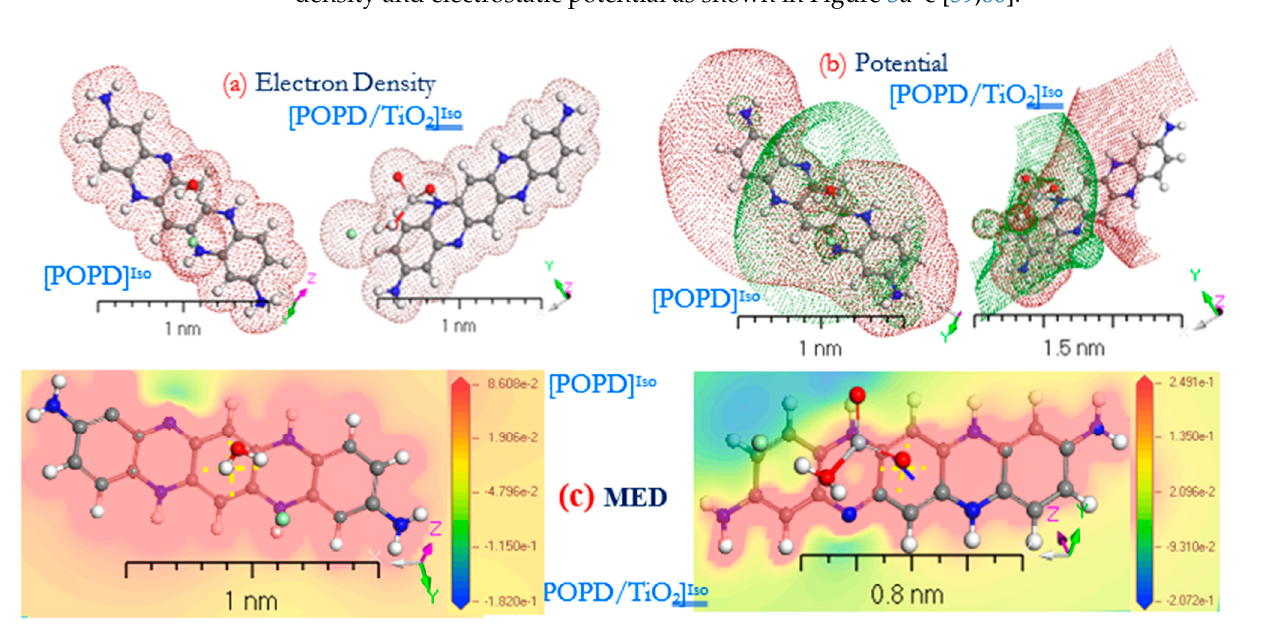
Figure 3. ( a ) Electron density for compounds [PoPDA] Iso and [PoPDA/TiO 2 ] Iso as an isolated molecule, ( b ) potential for compounds [PoPDA] Iso and [PoPDA/TiO 2 ] Iso as an isolated molecule, and ( c ) MEP of random and block for compounds [PoPDA] Iso and [PoPDA/TiO 2 ] Iso as isolated molecule utilizing TD-DFT/DMOl 3 programs.